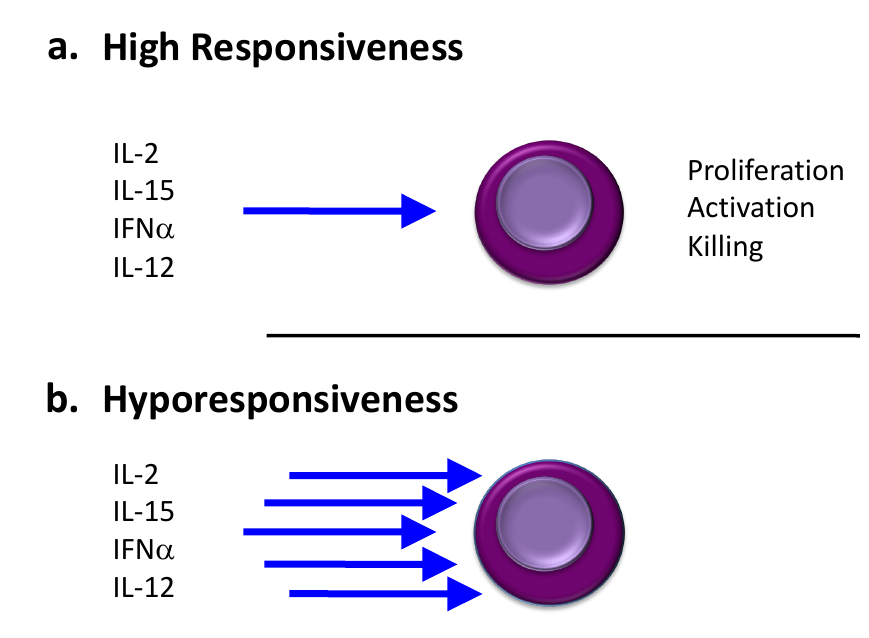
Figure 3. NK cell hyporesponsiveness after treatments. ( a ) NK cell functions could be increased by cytokine stimulation (blue arrows). ( b ) Repeated administration or sustained activation could result in NK cell